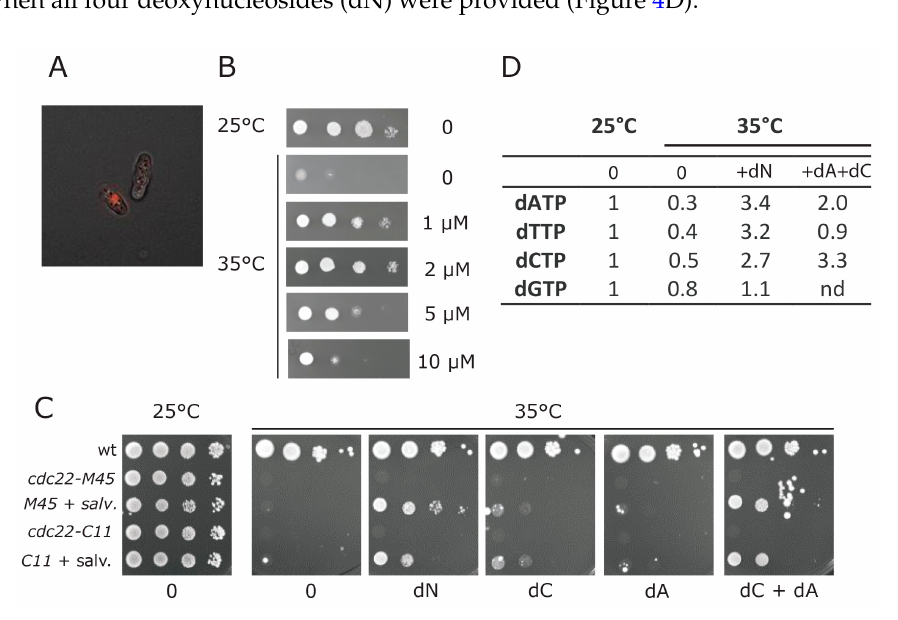
Figure 4. Establishment of a salvage pathway in fission yeast. ( A ) Incorporation of 5-ethynyl-2’-deoxyuridine (EdU) into cells expressing the salvage pathway. The fluorescence image shows a cell that incorporated EdU into its DNA and another cell that did not. ( B ) Growth of cdc22-M45 cells expressing the salvage pathway at 25 °C or at 35 °C. The plates at 35 °C contained the indicated concentration of dN (an equimolar mixture of dA, dC, dG and dT). ( C ) Growth of wild type cells, or cells harboring two different temperature-sensitive alleles of cdc22 (M45, C11), either with or without the salvage pathway at, respectively, 25 °C or at 35 °C. The plates at 35 °C contained 2 µM of the indicated deoxynucleoside. ( D ) Deoxynucleotide triphosphate (dNTP) pool measurements of a cdc22-M45 strain expressing the salvage pathway, grown either at 25 °C, or switched to 35 °C for four hours. When indicated, 4 µM of dN (as defined above) or 4 µM of dA + dC were added to the cultures at the time of temperature shift up. The relative levels of deoxynucleoside triphosphates were normalized to ATP and arbitrarily set to 1 at 25 °C. (nd: not determined).